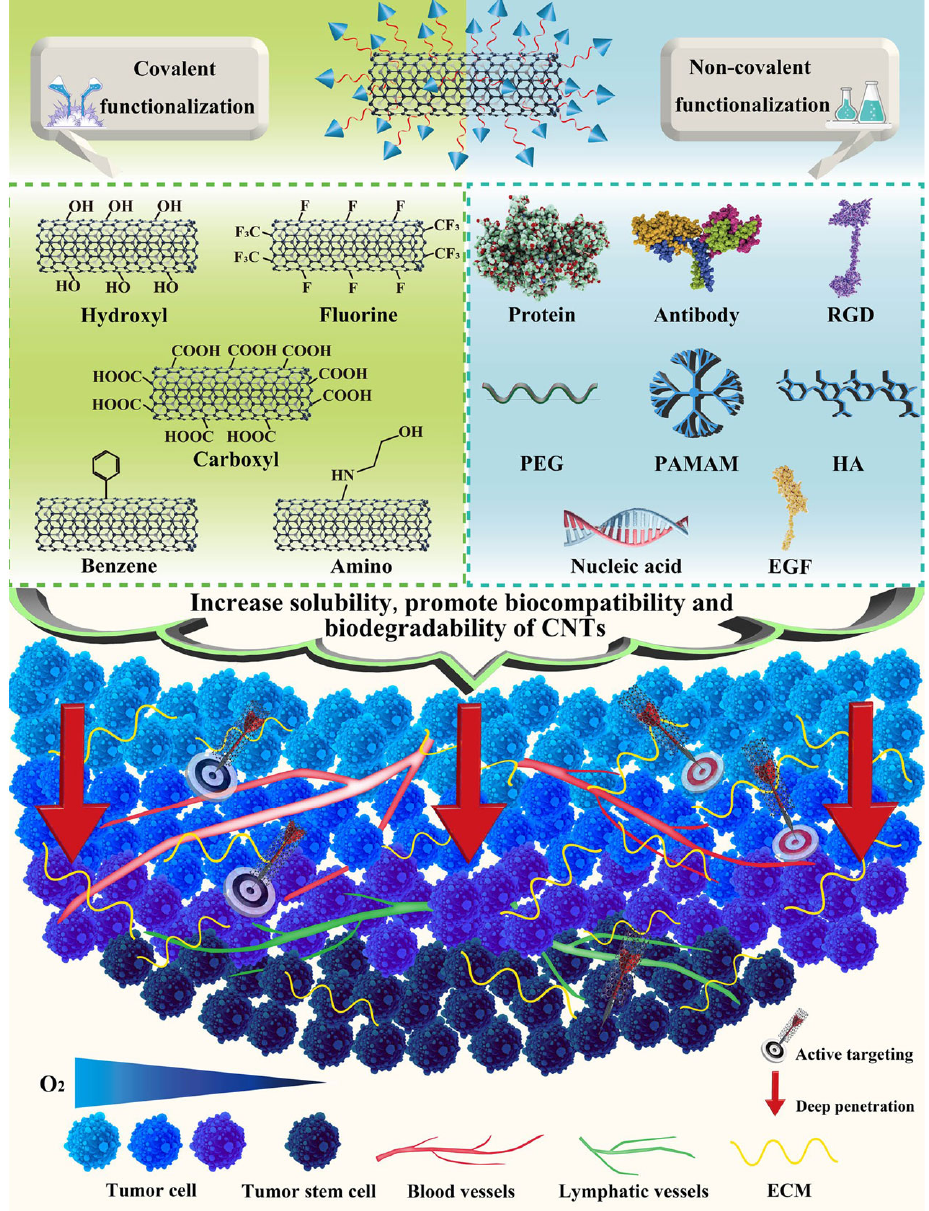
Figure 2. Schematic demonstration of various functionalization methods of CNTs via covalent and non ‐ covalent approaches for active drug delivery and deep tumor penetration [14].